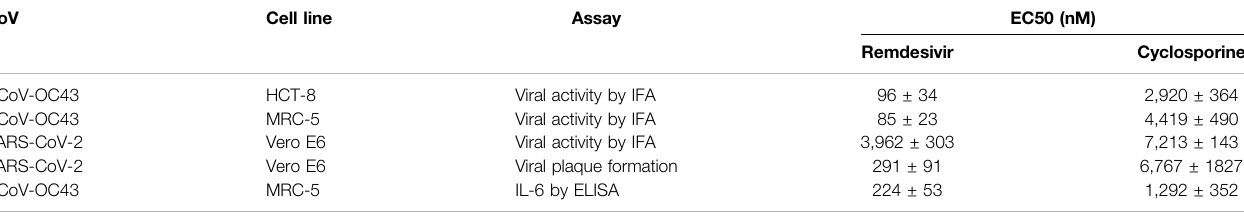
TABLE 1 | Antiviral activities and IL-6 reduction of remdesivir and cyclosporine against HCoV-OC43 and SARS-CoV-2. Shown are AVE ± SD from three independent experiments. CoV Cell line